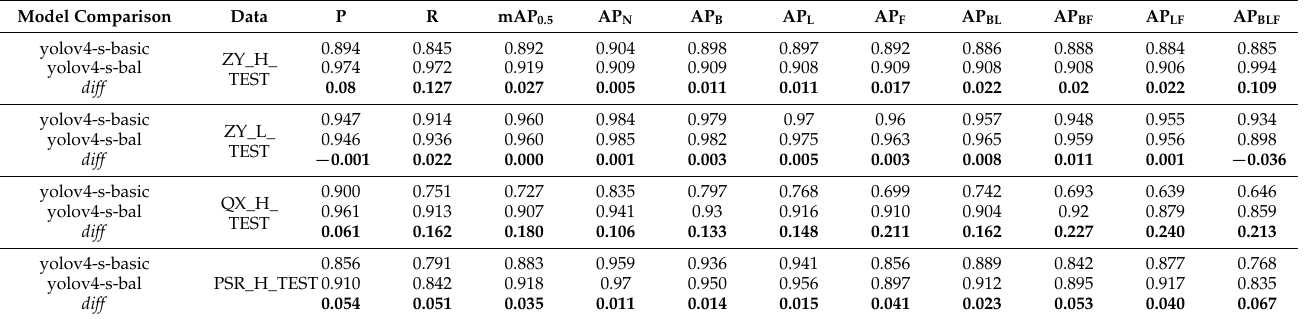
Table 7. Comparison of the statistical results of yolov4-s-basic and yolov4-s-bal for all metrics in the test dataset for each